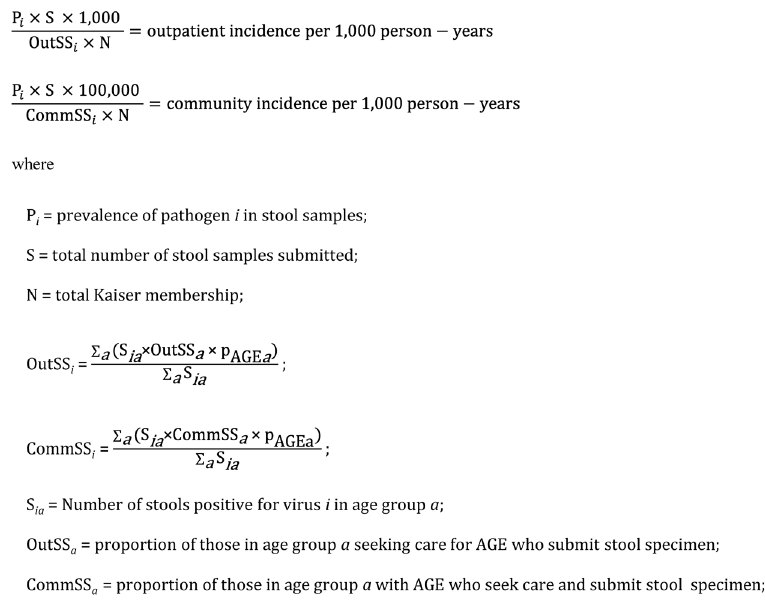
Fig 1. Equations used for calculation of community and outpatient incidence of viral pathogen in patients with acute gastroenteritis (AGE).